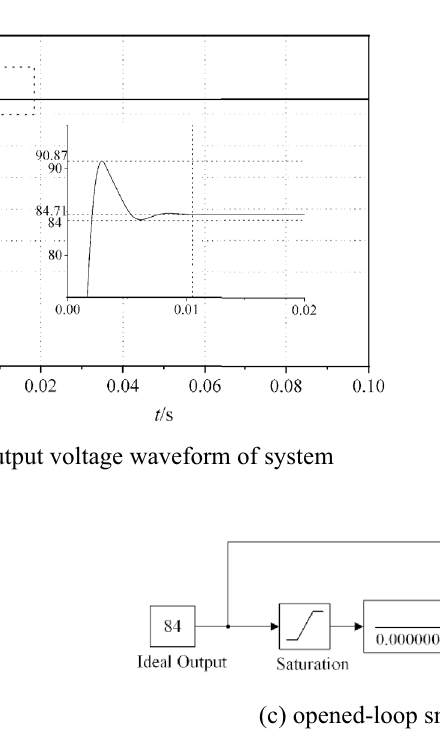
Figure 6. Simulation results of the opened-loop PSFD ZVS DC–DC